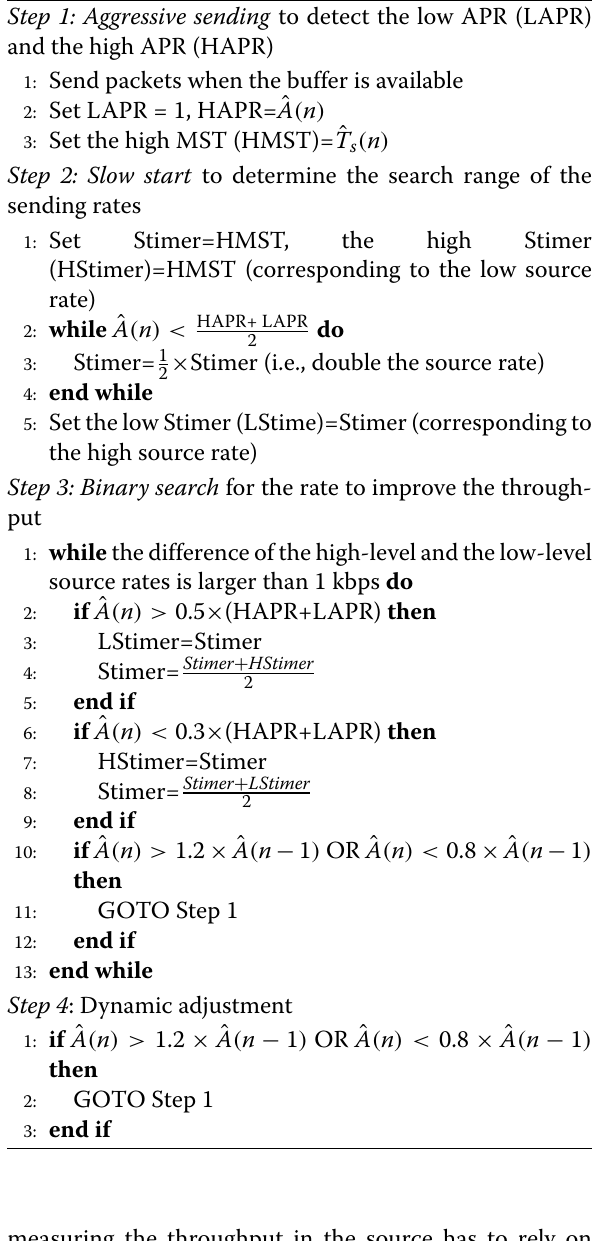
Algorithm 1 Binary search-based rate control